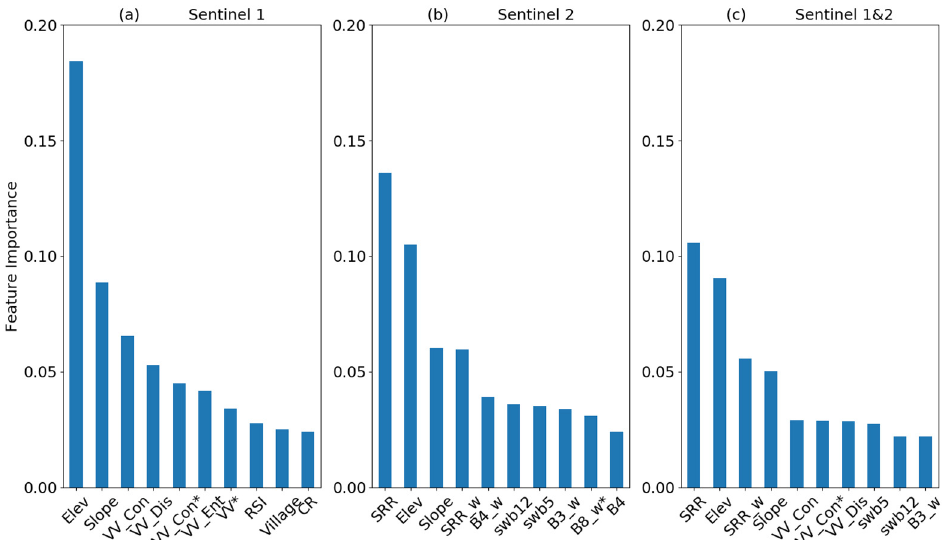
Figure 4. Bands contribution for Random Forest classification (top 10 features shown) for ( a ) Sentinel-1 only, ( b ) Sentinel-2 only ( c ) Sentinel-1 and 2 combined. Abbreviations as follows: Elev—Elevation, Dis—Dissimilarity, Con—Contrast, Homo—Homogeneity, Ent—Entropy, Corr—Correlation, Var—Variance, NDI—Normalised Difference Index, CR—Cross Ratio., wsb is ratio of winter and summer bands. Underscore indicates GLCM feature for S ‐ 1 or winter image for S ‐ 2. For both S ‐ 1 and S ‐ 2 asterix * indicates standard deviation of given feature.